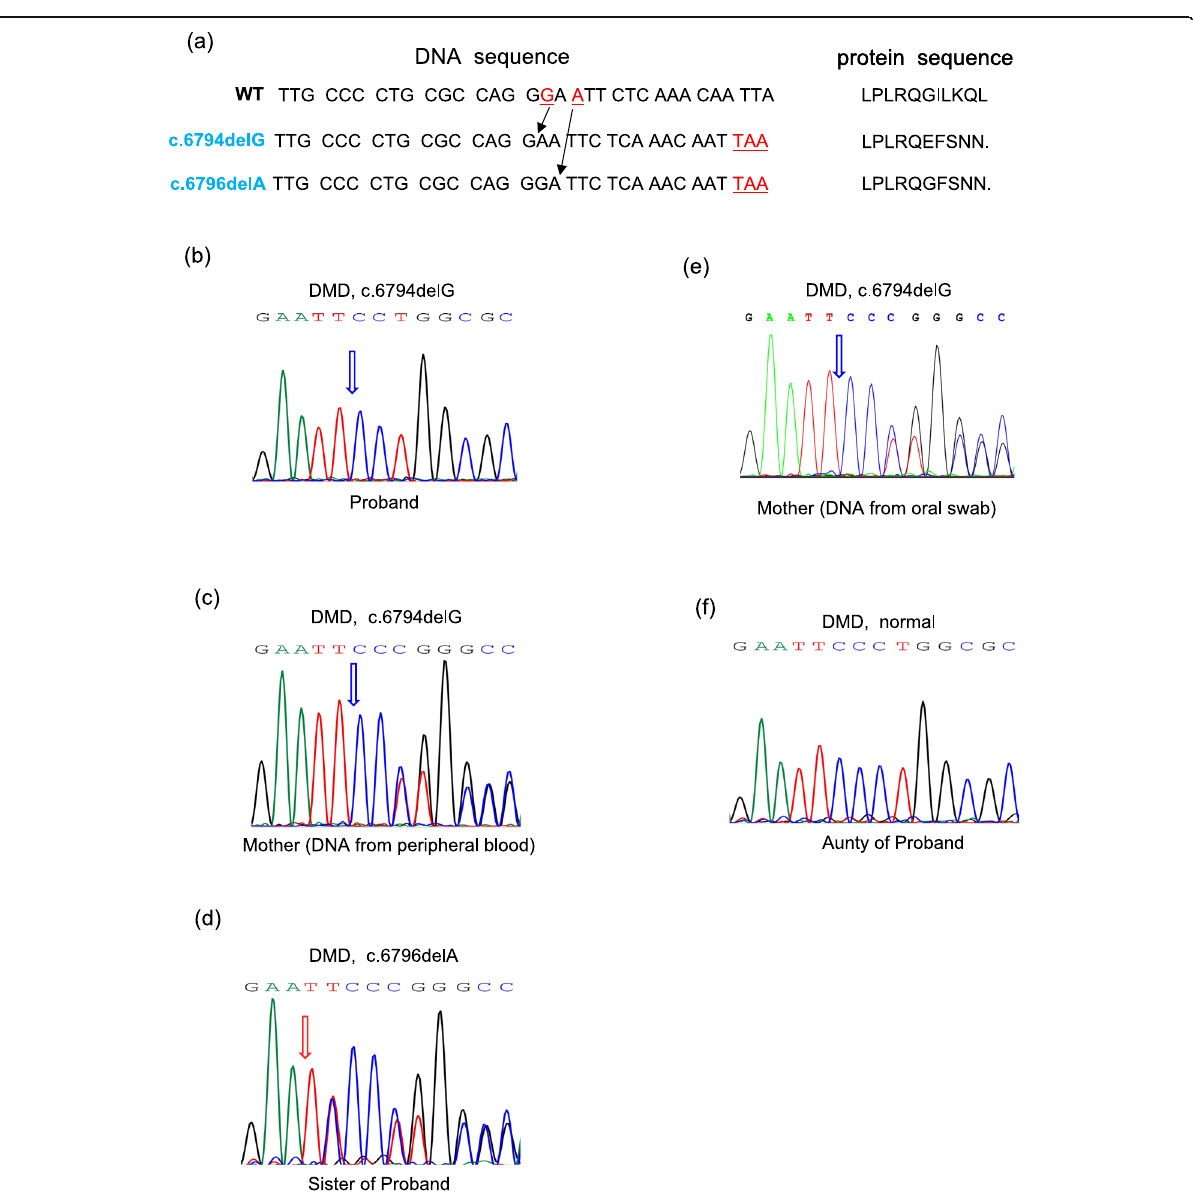
Fig. 3 Sanger analysis for the Dystrophin gene of the designated family members. a Overview of identified mutations. Note that c.6794delG mutant generated a truncated dystrophin protein (p.Gly2265Glu Efs × 6), while c.6796delA mutant resulted in a truncated dystrophin protein (p.Ile2266phe Efs × 5). b-f Confirmation of the mutations by Sanger sequencing from the proband ( b ), the mother ( c , e ), the sister of the proband ( d ), and the aunty of the proband ( f ). Reference sequence for Dystrophin gene: